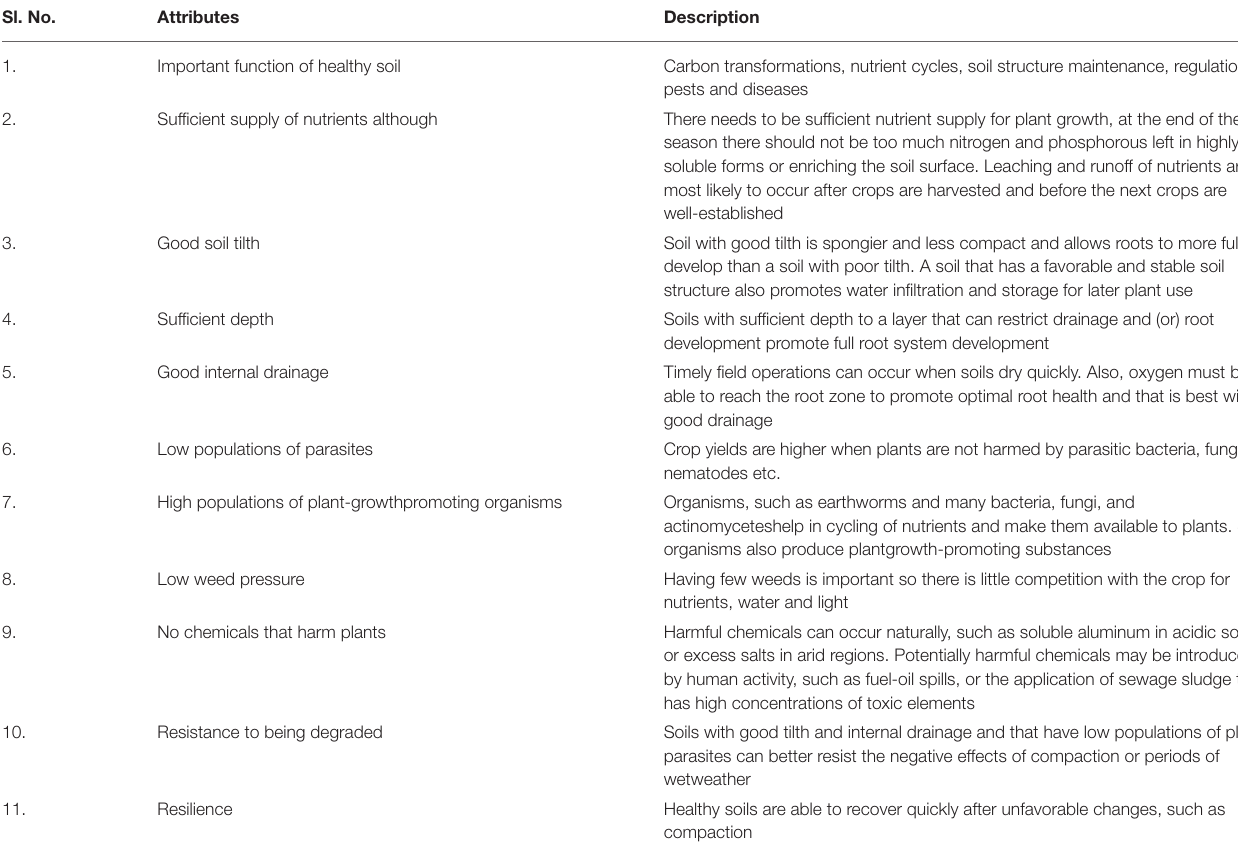
TABLE 4 | Characteristics of healthy soil. Sl.